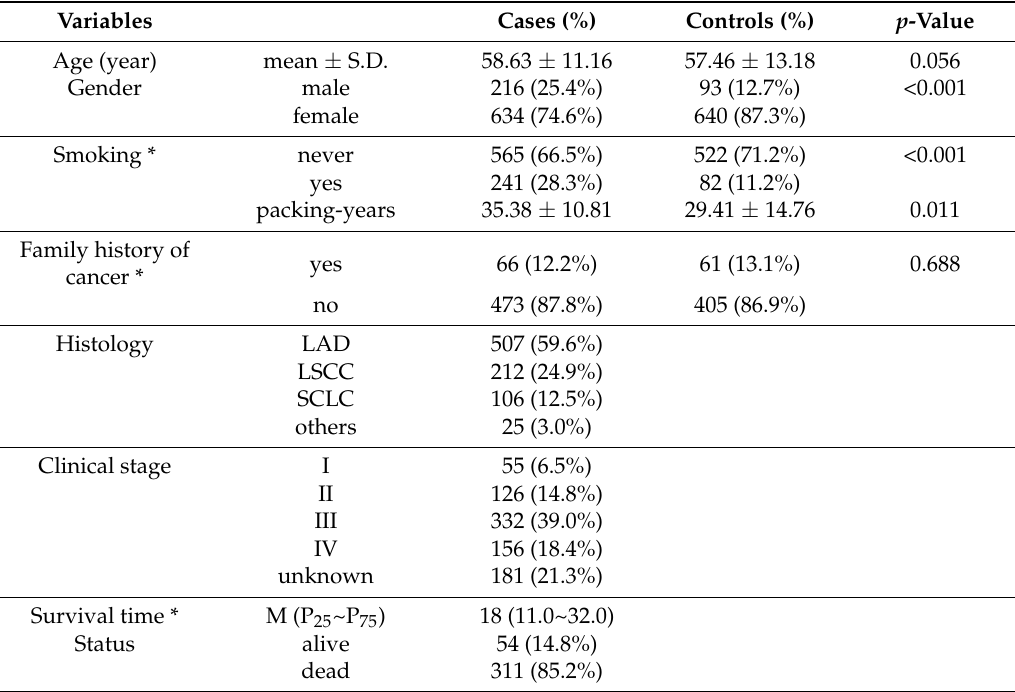
Table 1. Demographics of lung cancer patients and control.